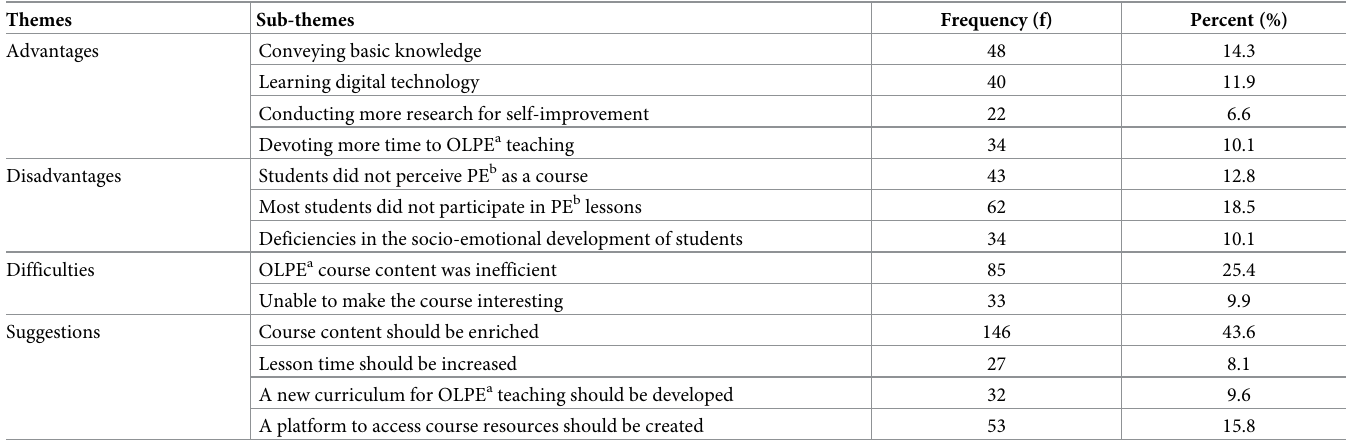
Table 5. Pets’ opinions on online physical education